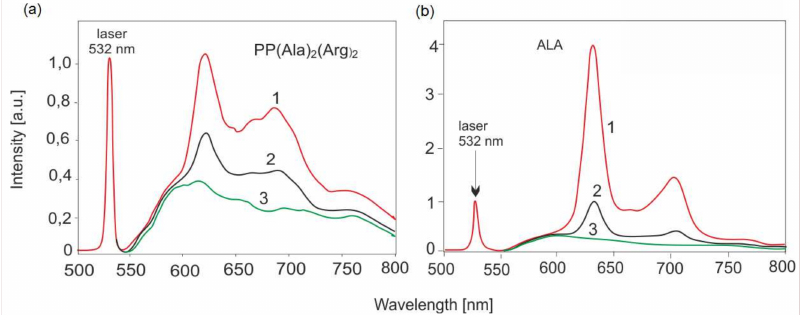
Comparison of accumulated porphyrin concentrations in ( a ) cervical cancer PP (Ala) 2 (Arg) 2 and ( b ) vaginal (ALA): 1—tumor in the center of lesions, 2—tumor on the border, 3—normal tissue.